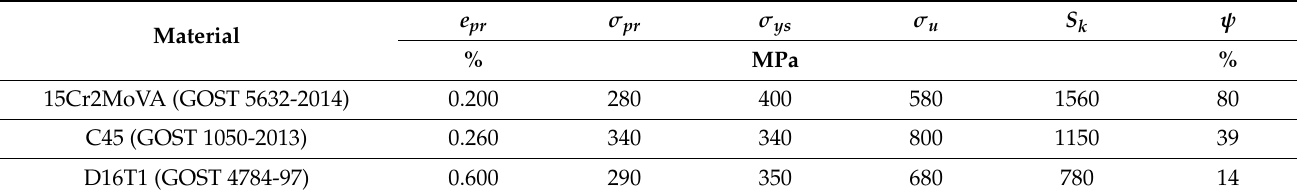
Table 2. Mechanical properties of the materials.